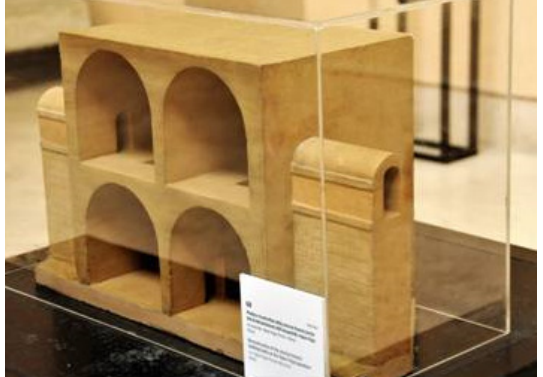
Figure 6. Roman times model (reconstruction) of the settling tanks (piscina limaria) on the aqueduct Virgo at the Pincian Hill in Rome, which is located in the Roman Civilization Museum in Rome [6] .